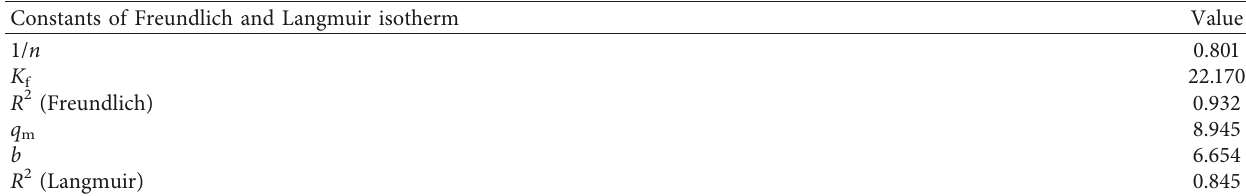
2 powders with different compositions.